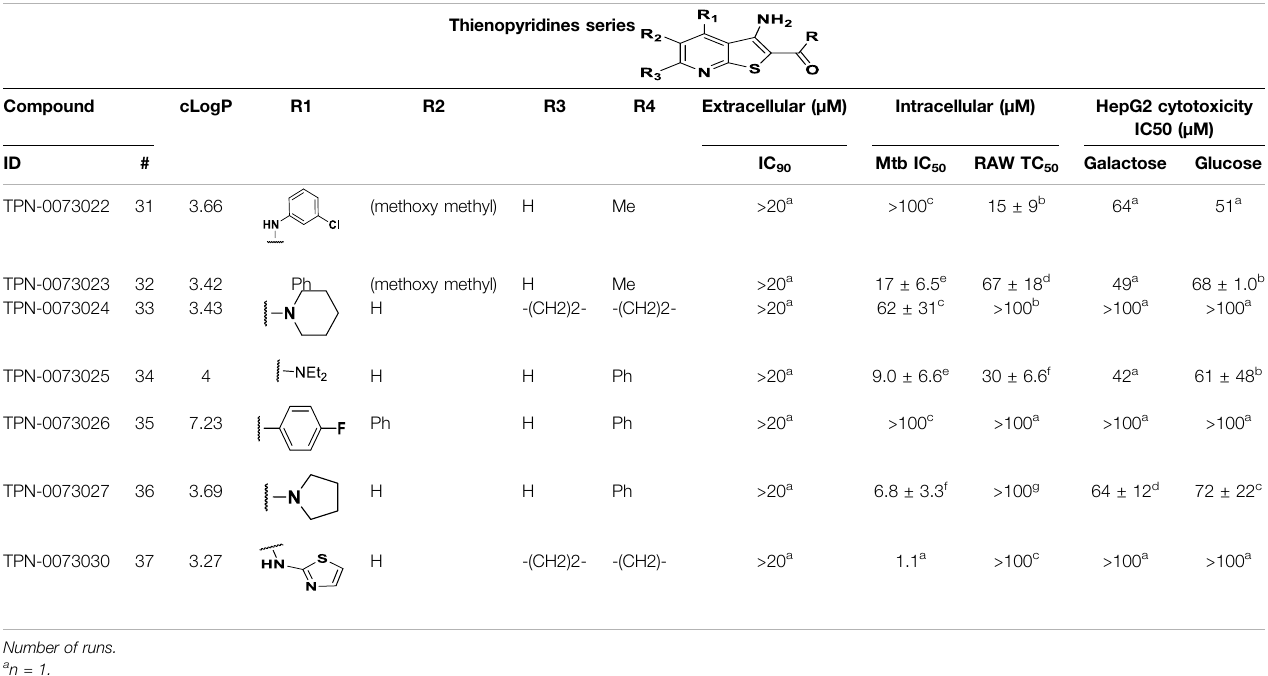
TABLE 8 | Catalog structure-ctivity relationship of the TIP